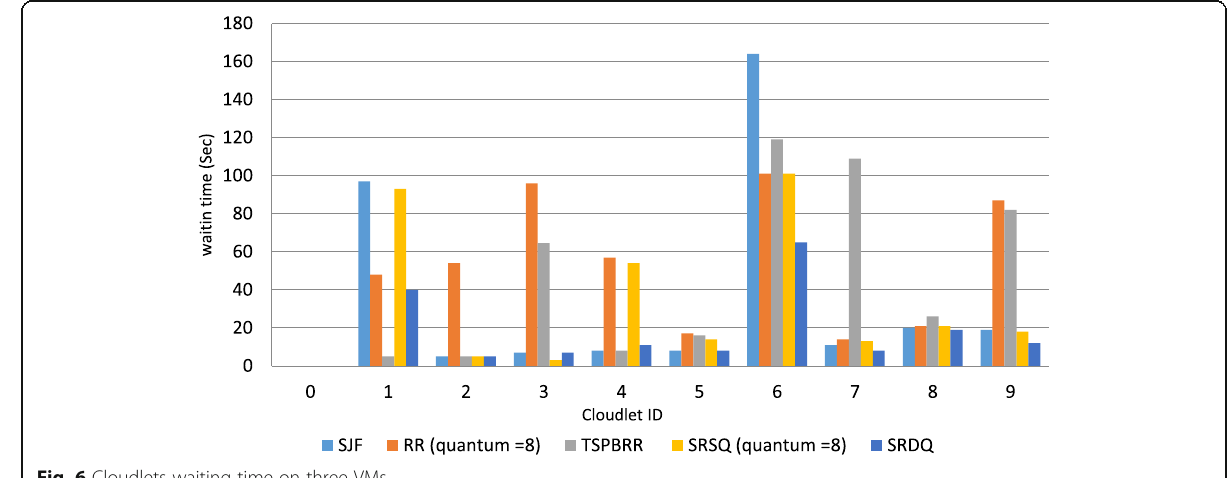
Fig. 6 Cloudlets waiting time on three